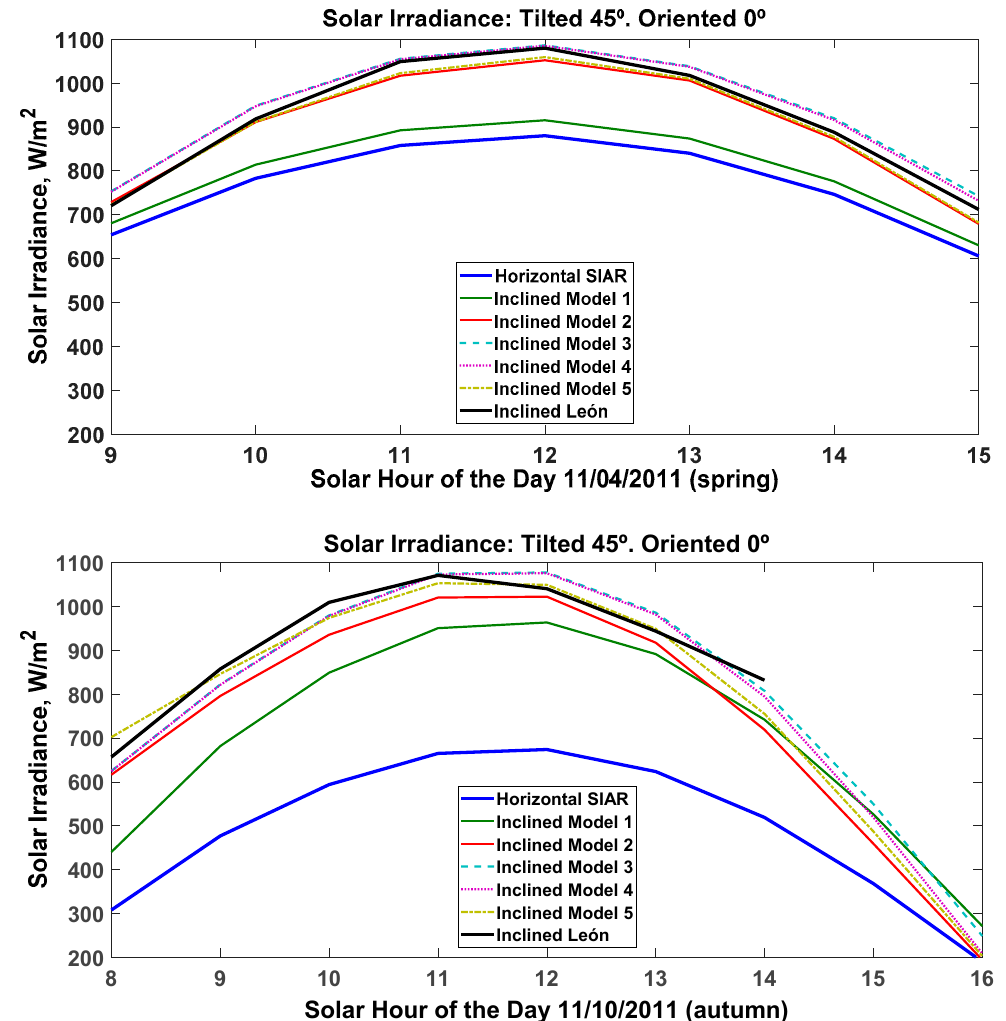
Figure 10. Hourly solar irradiance obtained for a single day from the horizontal SIAR in Mansilla Mayor (León, Castile and León region, Spain) compared with that estimated for a solar panel inclined at 45° and oriented to the equator with Inclined Models 1, 2, 3, 4, and 5. ( Top ) 11 April 2011 (spring); ( bottom ) 11 October 2011 (autumn). Table 1. Observed adjustment of the hourly solar irradiance on the plane inclined at 45° and oriented towards the equator, as estimated with Inclined Models 2, 3, 4, and 5 from data for the horizontal surface from the agrometeorological station SIAR in Mansilla Mayor (León, Castile and León, Spain), along with the values measured in León, for four days.